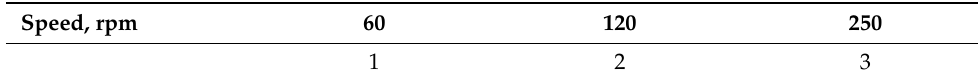
Table 4. Mixing speeds used for the preparation of the blends.